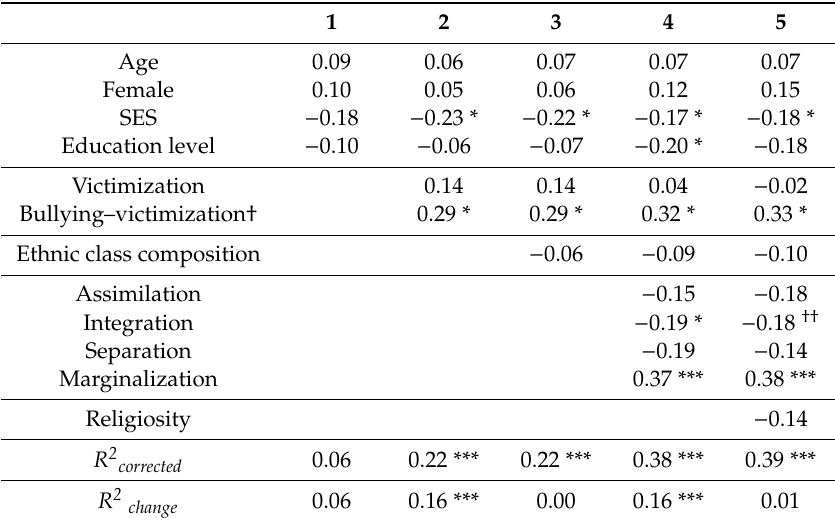
Table 3. Multiple hierarchical regression analysis on depressive